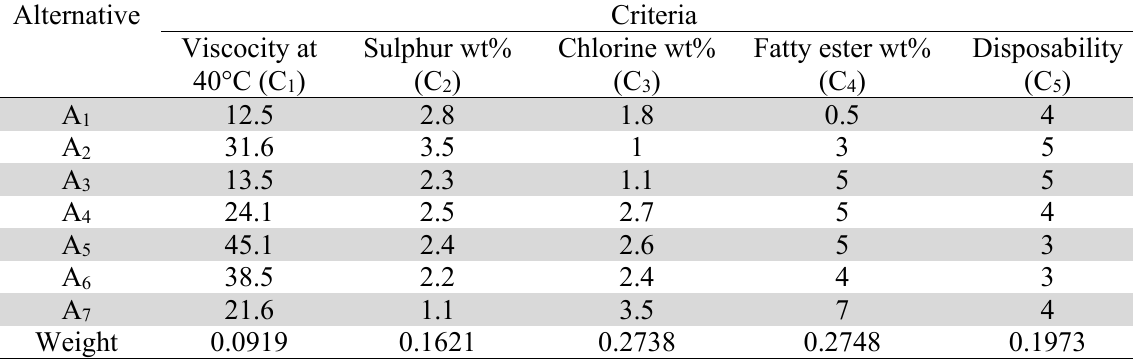
Table 1. Decision matrix for neat oil selection problem